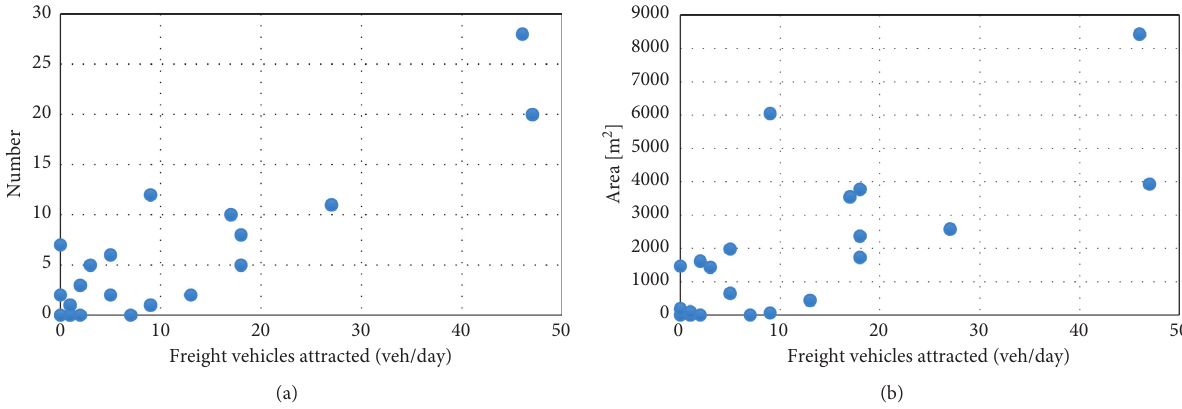
Figure 4: Number (a) and area (b) of commercial activities versus the number of attracted freight vehicles. Commercial activities of all